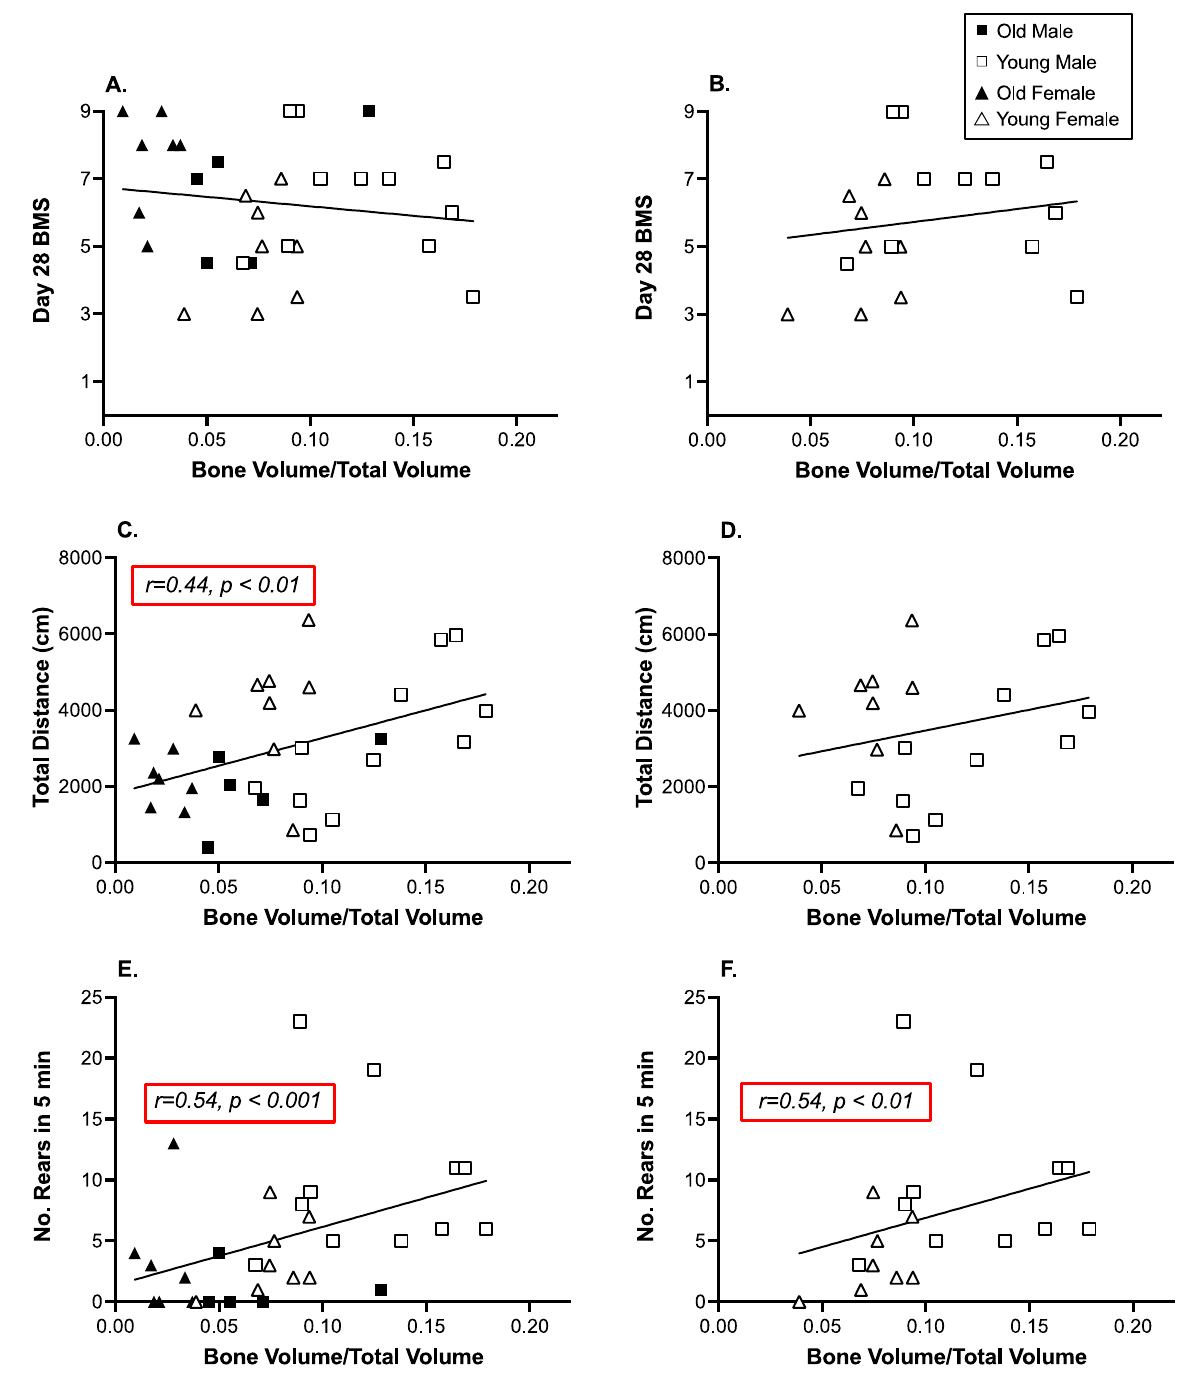
Figure 6. There was no correlation between trabecular bone volume and locomotor function per se, but open field activity and rearing were associated with increased bone volume. ( A ). BMS scores collected on Day 28 were not correlated with bone volume across all SCI mice or ( B ). in young SCI mice only. ( C ). There was a strong correlation between open field activity (on Day 21 post injury) and tibia bone volume. ( D ). The correlation between open field activity was not seen in the young mice per se, but was clear for young male mice alone. ( E ). Rearing was also strongly correlated with tibia trabecular bone volume. ( F ). This effect was also clear in the young SCI subjects alone and particularly in the young female subjects. n = 5 SCI old and 11 SCI young males; 7 SCI old and 8 SCI young